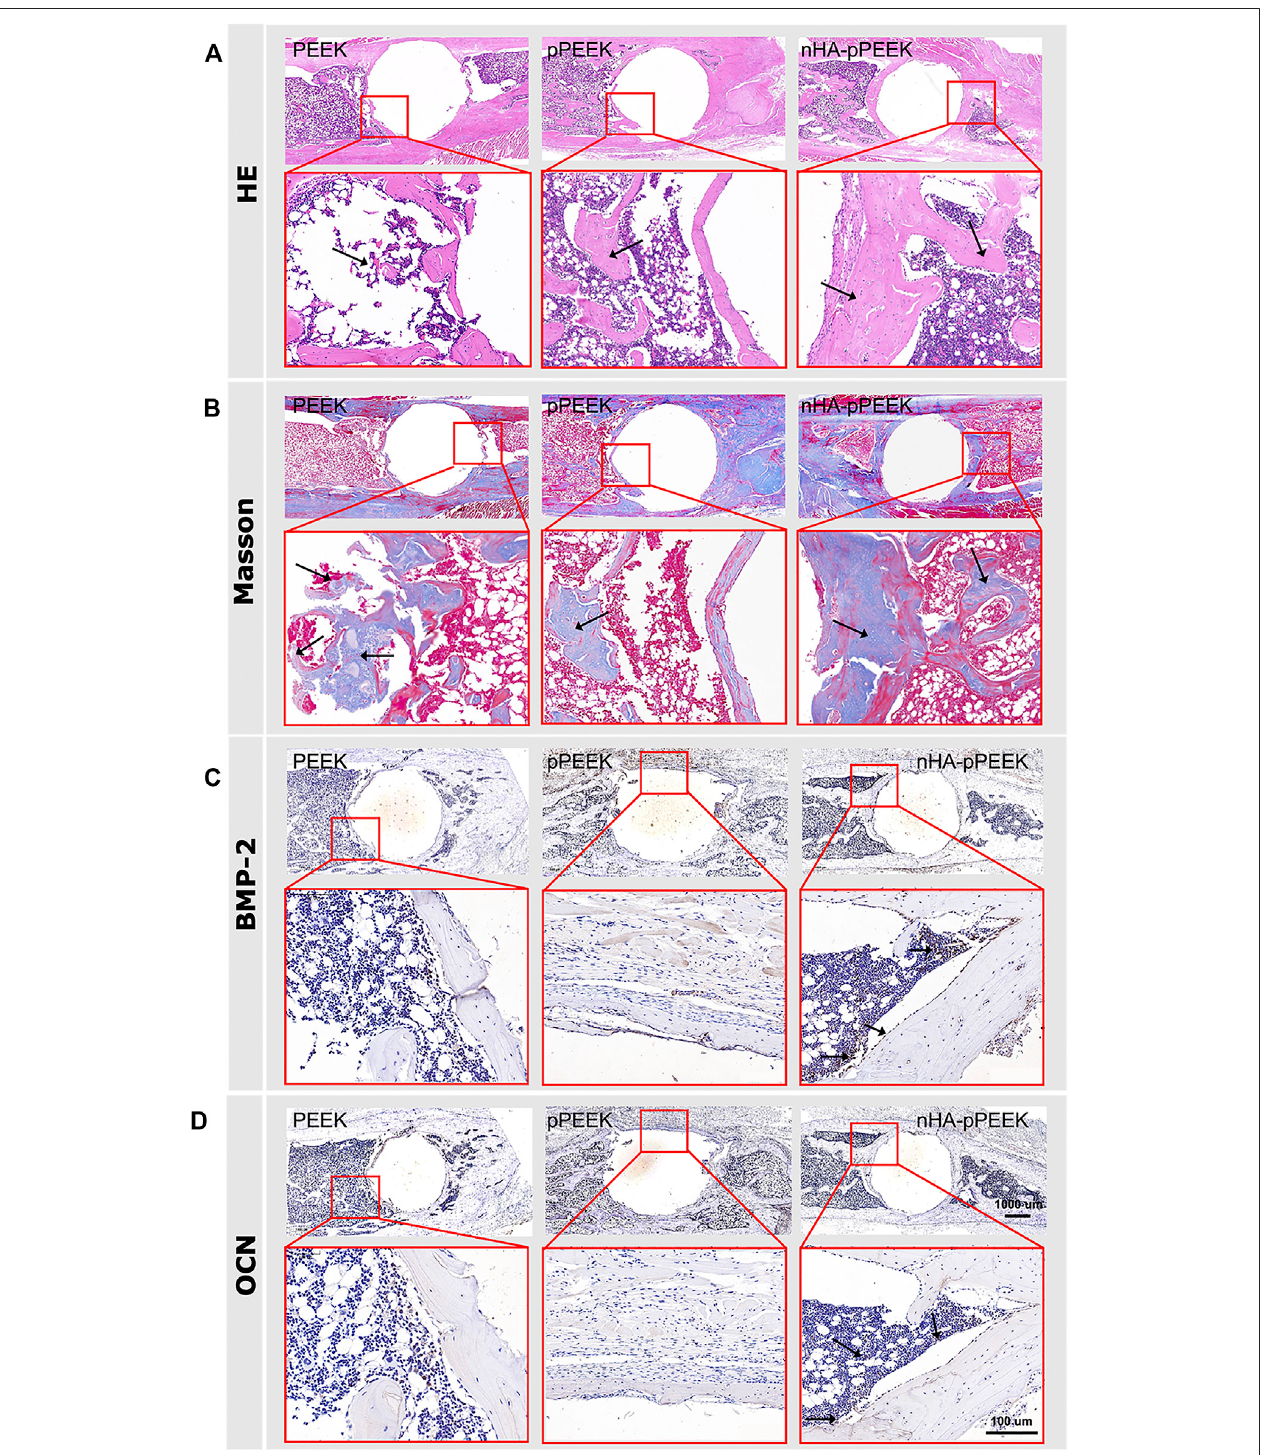
FIGURE 5 | Histological analysis. (A) Representative displays of hematoxylin – eosin (HE) staining of tibia tissue sections, revealing that nHA-pPEEK composites markedly promoted new bone formation (black arrows). (B) Results of MTC staining for the collagenous fi ber distinguished as blue (black arrows), showing that the experimental grouphad alargenumber ofblue collagen fi brilsand fi brous tissue. (C) Results ofBMP-2 protein immunolocalization via immunohistochemistry stainingto make a successful differential diagnosis (black arrows). (D) OCN immunolocalization via immunohistochemistry stainingto make asuccessful differential diagnosis (black arrows).